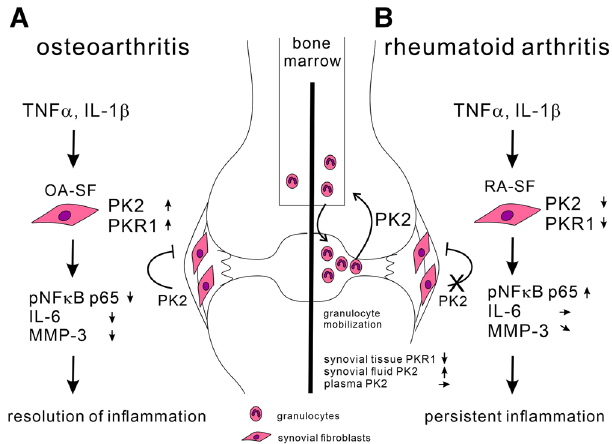
Figure 8. Model describing the dysregulation of endogenous inflammation by PK2 in arthritis. In OA, exposure to proinflammatory cytokines upregulates the expression of PKR1. PK2 secreted from OA-SF acts on PKR1 in an autocrine or paracrine manner and reduces the secretion of IL-6 and MMP-3 from OA-SF ( A ). In contrast, in RA-SF, exposure to proinflammatory cytokines downregulates the expression of PK2 and PKR1 ( B ). Therefore, PK2 exhibits a weaker anti-inflammatory effect in RA-SF compared with OA-SF. Indeed, the expression of PKR1 in RA synovial tissue was decreased compared with OA synovial tissue. This dysregulation in the endogenous inflammation-mediated modulation of PK2 in RA-SF may be associated with the chronicity of inflammation in the pathogenesis of RA. PK2 prokineticin 2, PKR1 prokineticin receptor 1, OA osteoarthritis, RA rheumatoid arthritis, SF synovial fibroblasts, IL-1β interleukin-1β, TNFα tumor necrosis factor α, IL-6 interleukin-6, MMP-3 matrix metalloproteinase 3, pNFκB phospho nuclear factor kappa-light-chain-enhancer of activated B